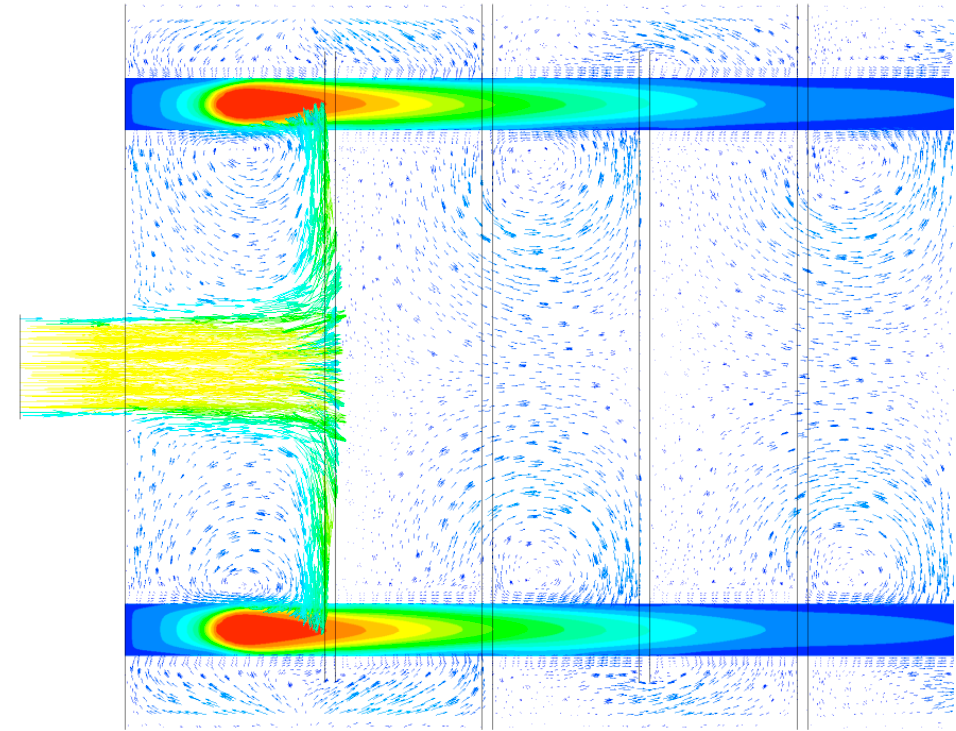
Figure 11. Effect of 20 K inlet temperature rise on the reactor. Hot-spot position and coolant velocity overlay field at t = 120 s.